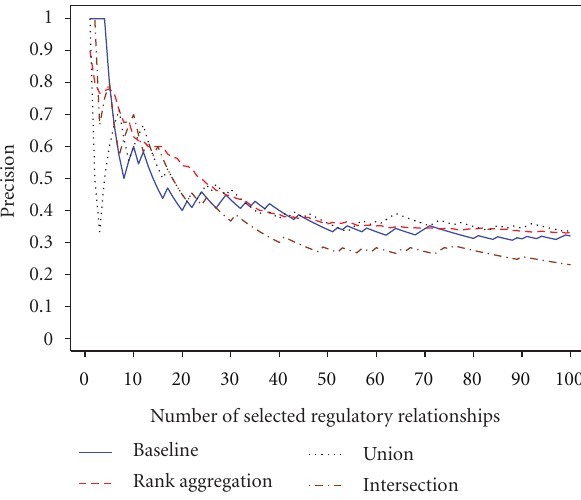
Figure 4: Comparison of precision given by the rank aggregation at k = 25, 50, 75, and 100. Figure 5: Comparison between precisions of integration methods